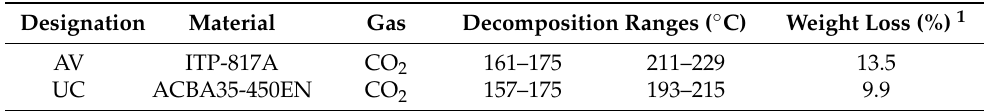
Table 2. Properties of the CBAs used in this study. Decomposition temperatures and %weight loss are determined from differential scanning calorimetry (Figure S1) and thermogravimetric analysis data (Figure S2),